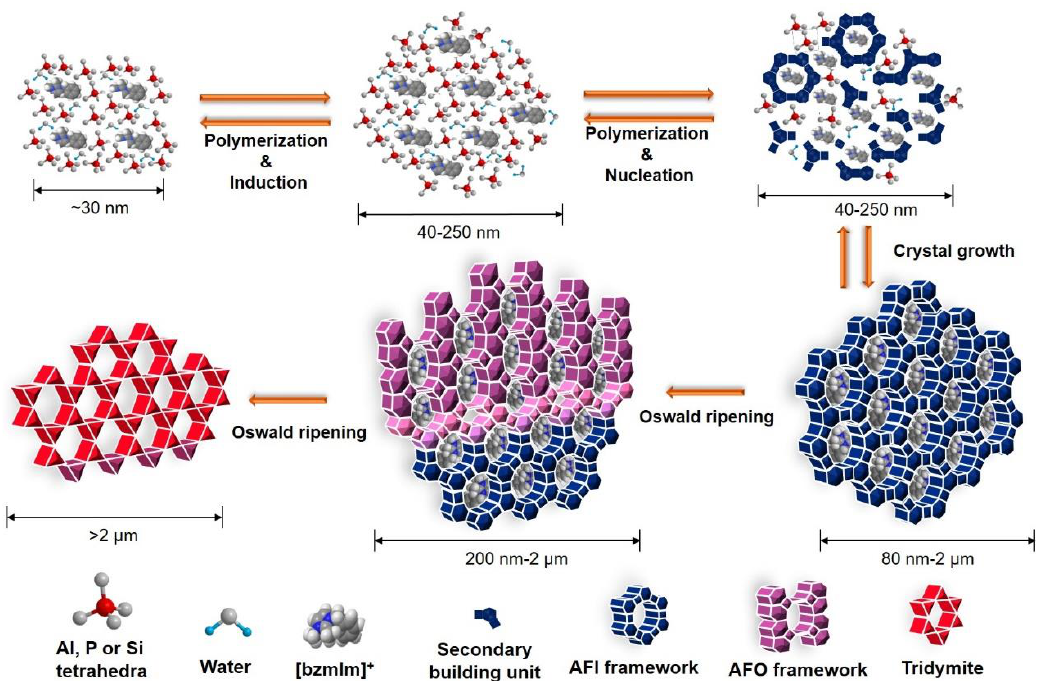
Figure 13. The hydrothermal crystallization pathway of SAPO-5 templating using [bzmIm]OH.